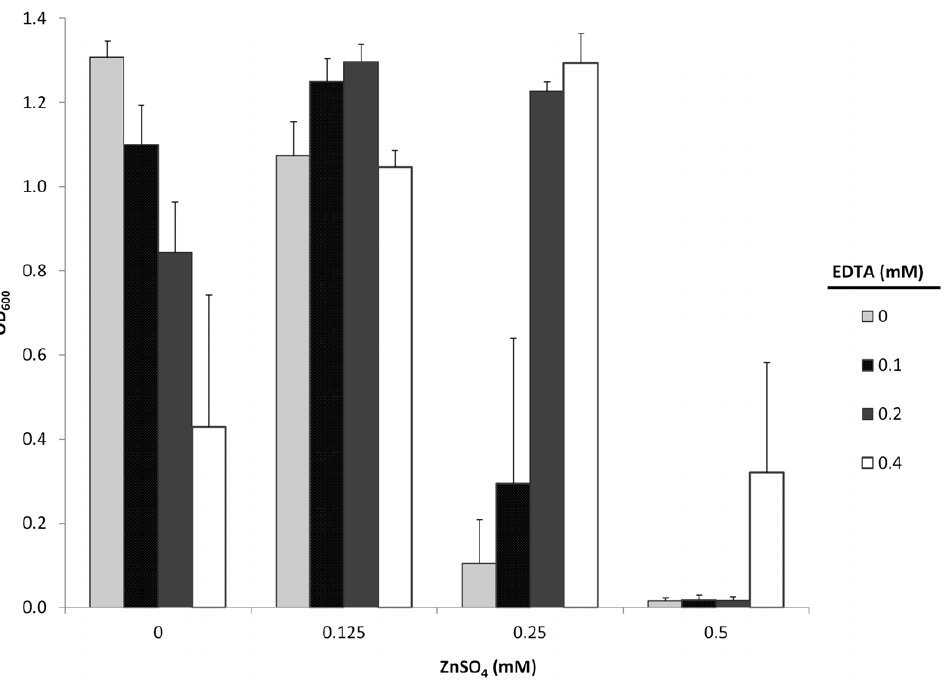
Figure 6. Growth of S.meliloti in zinc repleted media. Increasing concentrations of ZnSO4, ranging from 0 to 0.5 mM (x-axis), was added to media containing different amounts of EDTA (light grey bars: 0 mM, black speckled bars: 0.1 mM, dark grey bars: 0.2 mM, and white bars: 0.4 mM). The growth of S. meliloti in each media was determined by measuring the absorbance of the culture at 600 nm (OD600) , 20 hrs post inoculation. Data shown is an average of three independent trials with three replicates grown per trial. Error bars shown represent the standard deviations.